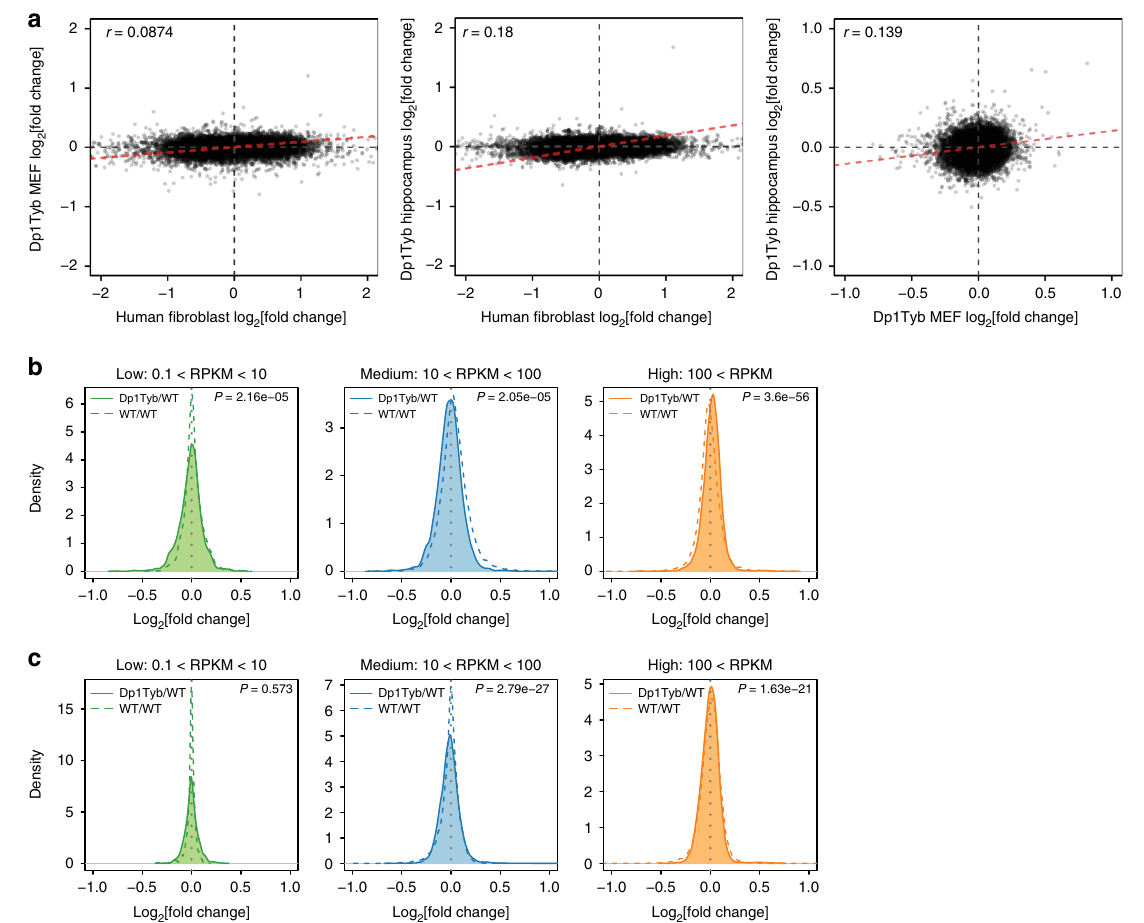
Fig. 4 Very little correlation in gene expression changes between human Down syndrome (DS) and mouse Dp1Tyb fi broblasts or hippocampus and no preferential upregulation of lower expressed genes. a Correlation plots showing the fold change in gene expression comparing human DS vs euploid fi broblasts with Dp1Tyb vs wild-type (WT) mouse embryonic fi broblasts (MEFs) or hippocampus or comparison of the Dp1Tyb MEFs with hippocampus. Each dot is a gene (in human vs mouse comparisons orthologous genes were used). Dashed red line indicates best fi t regression line. Correlation coef fi cient r is indicated for each comparison. Hsa21 genes and their mouse orthologues were excluded from the analysis. b , c Density plots of fold change in gene expression between Dp1Tyb vs WT MEFs ( b ) or hippocampus ( c ) (solid line) divided according to the level of gene expression: low (0.1 < RPKM < 10), medium (10 < RPKM < 100), high (100 < RPKM). Dashed line shows similar plots of a comparison of gene expression between two WT samples and two other WT samples. Statistical signi fi cance was calculated using Mann – Whitney test